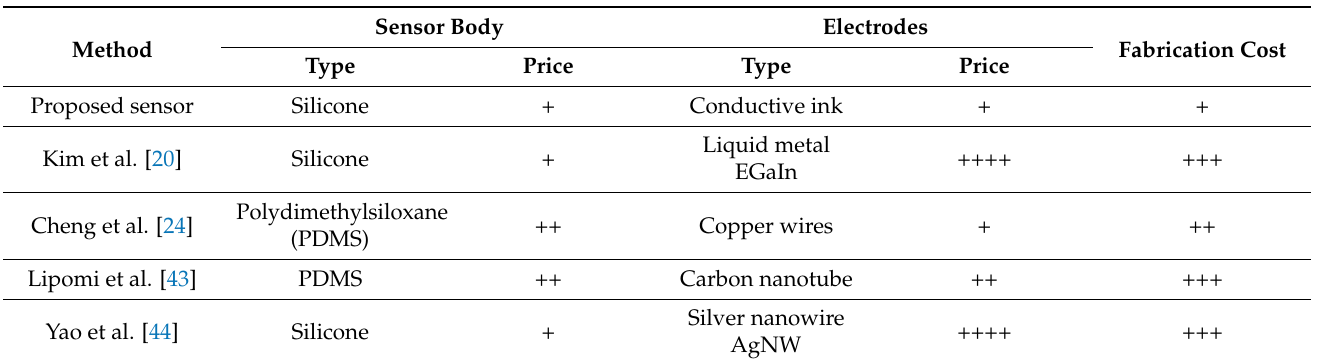
Table 2. Comparison of the total cost of our proposed soft tactile/capacitance sensor with previous well-known